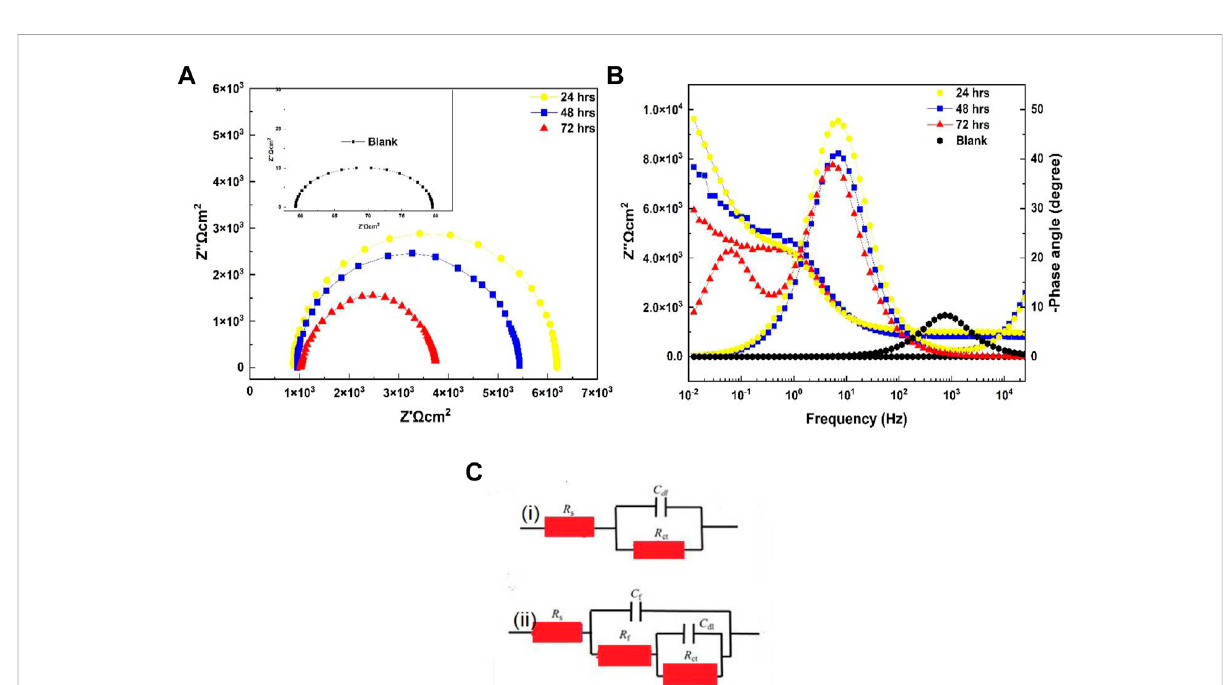
FIGURE 8 Diagram of electrochemical impedance spectroscopy. (A) Nyquist plot. (B) Bode and phase angle plots of blank aluminum 6101 with coated samples in a 0.001M NaOH solution. (C) Equivalent electrical circuits for EIS results: (i) blank aluminum and (ii) coated